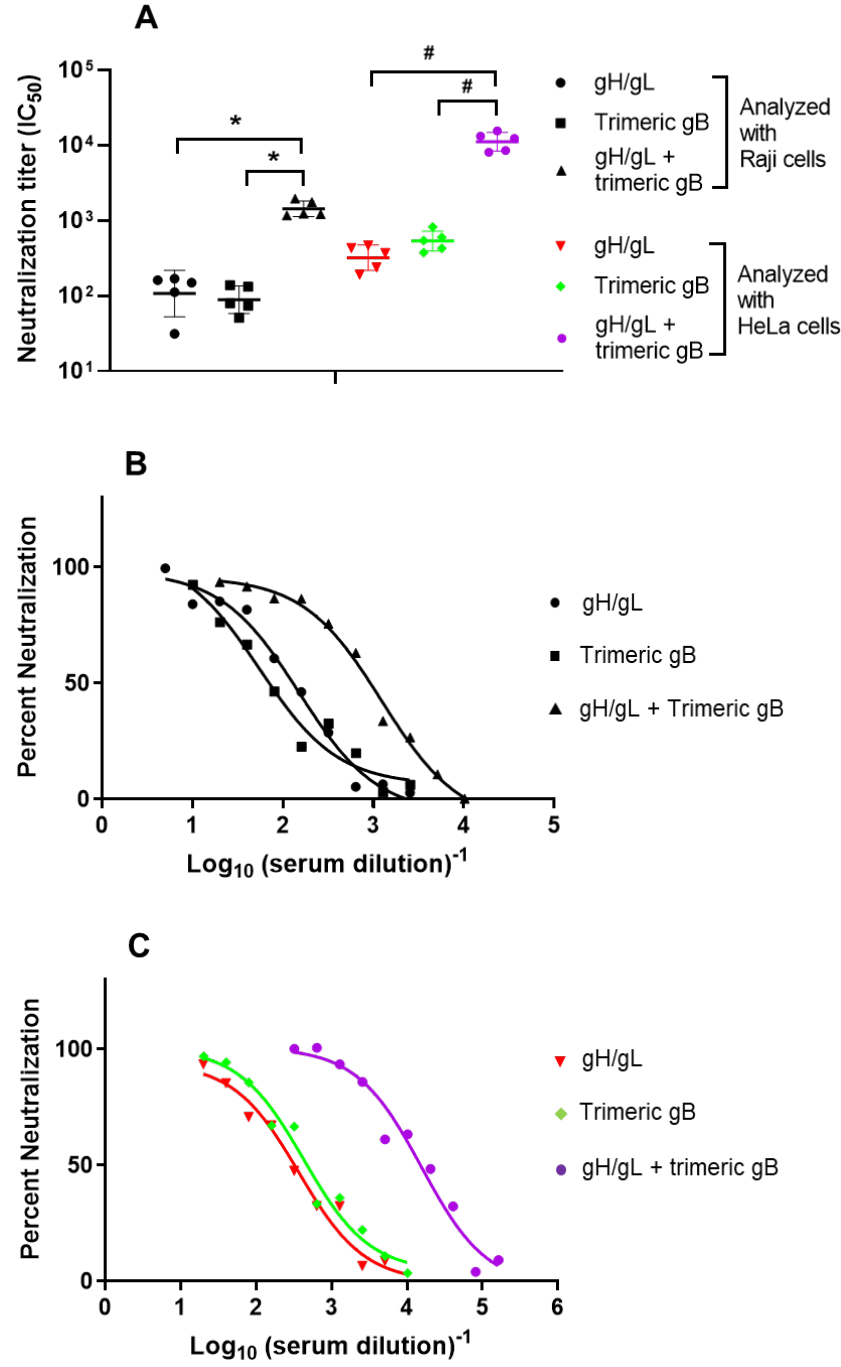
Figure 3. Immunization of rabbits with the combination of EBV gH/gL and trimeric gB demonstrated strong synergistic neutralizing activity preventing EBV infection of Raji cells and HeLa cells. Day 52 immune sera from rabbits ( n = 5) subcutaneously immunized three times with 25 µg of recombinant EBV gH/gL, EBV trimeric gB or the combination of EBV gH/gL and trimeric gB (25 µg each) adjuvanted with alum + CpG-ODN were heat-inactivated. ( A ) Serum IC 50 neutralizing titers were determined using Raji/HeLa cells and EBV strain B95-8 GFP as indicated. Significance *, # p < 0.05 compared to the EBV neutralizing activities of the sera from rabbits immunized with individual envelope proteins. ( B ) Calculation of IC 50 by non-linear regression analysis using Raji cells and EBV strain B95-8 GFP. ( C ) Calculation of IC 50 by non-linear regression analysis using HeLa cells and EBV strain B95-8